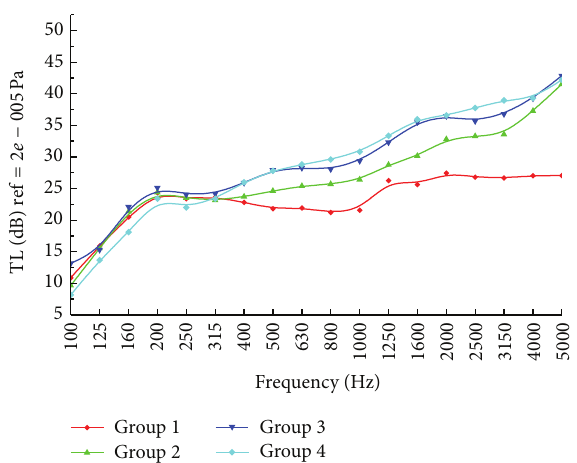
Figure 10: Curves of transmission loss of the PU foams of varying water contents and 141b. (a) Group 1 with water 3.8 parts by weight, (b) Group 2 with water 4.1 parts by weight, (c) Group 3 with water 4.4 parts by weight, and (d) Group 4 with water 4.7 parts by weight.